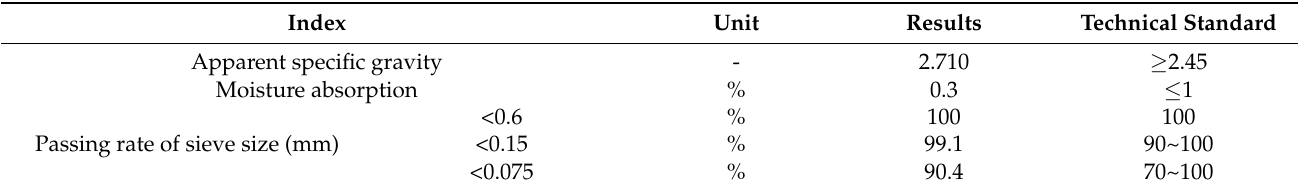
Table 3. Physical characteristics of mineral powder.